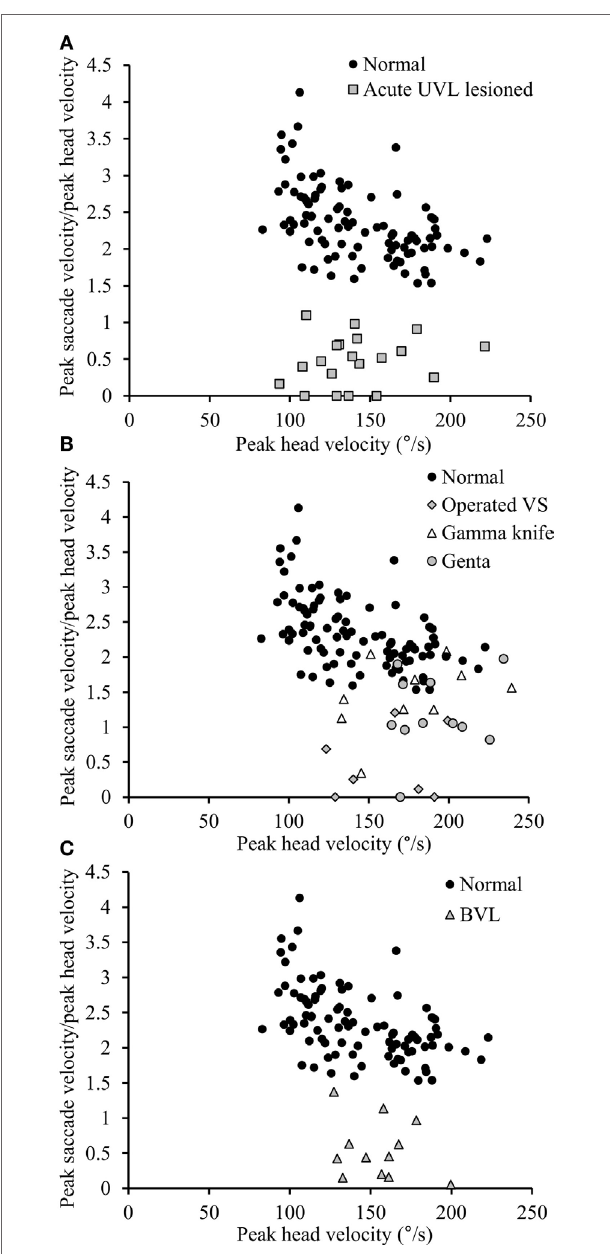
FigUre 5 | relationship between peak saccade velocity and peak head velocity . (a) The ratio between peak saccade velocity (°/s) and peak head velocity (°/s) is close to 2.5 in normal subjects (black circles), whereas it is lower than 1.10 in acute UVL patients (gray squares). (B) The ratio varies from 0 to normal values in chronic UVL patients. Notice that normal values were only seen in some patients treated with gamma-knife therapy because of unilateral vestibular schwannoma (empty triangle) or patients suffering from Meniere’s disease and treated by intratympanic gentamycin injections (gray circles), but not patients with vestibular schwannoma operated after 6 weeks (gray diamonds). (c) The ratio in BVL patients (gray triangles) is lower than 1.37.